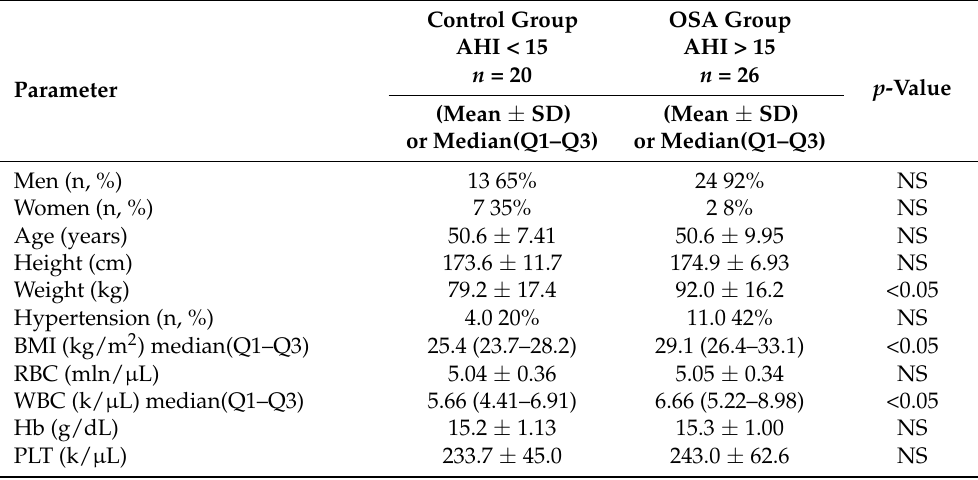
Table 1. The baseline characteristics of groups including cardiovascular risk stratification. The results are presented as mean ± SD or median ±